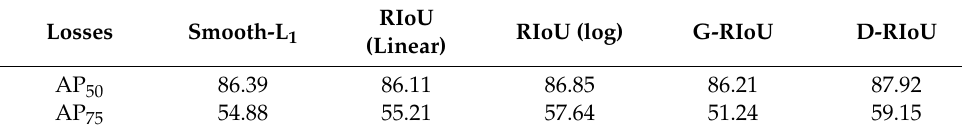
Table 4. Analysis of different training losses on HRSC2016 dataset.